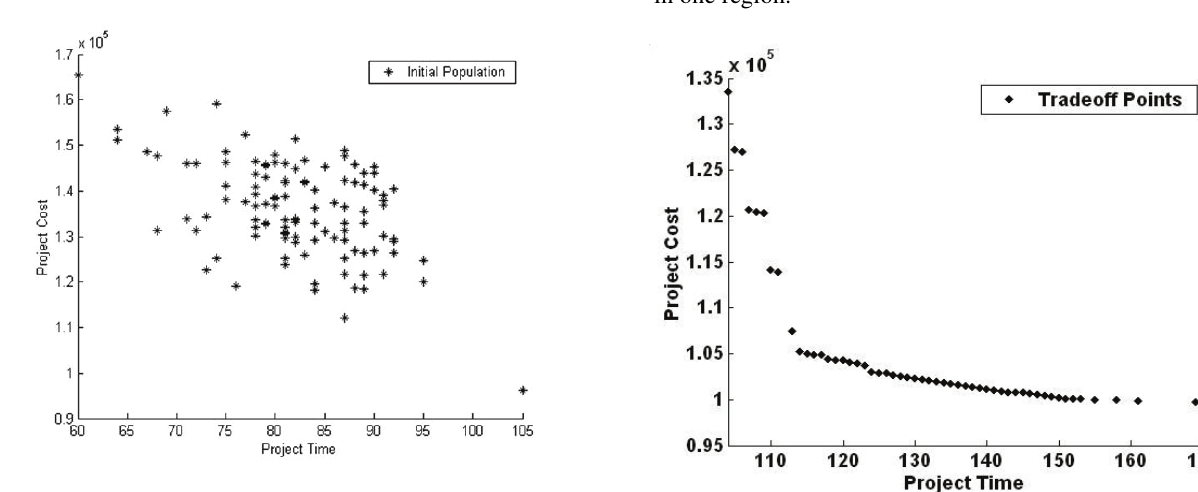
Fig. 13. Tradeoff Points of the final generation population